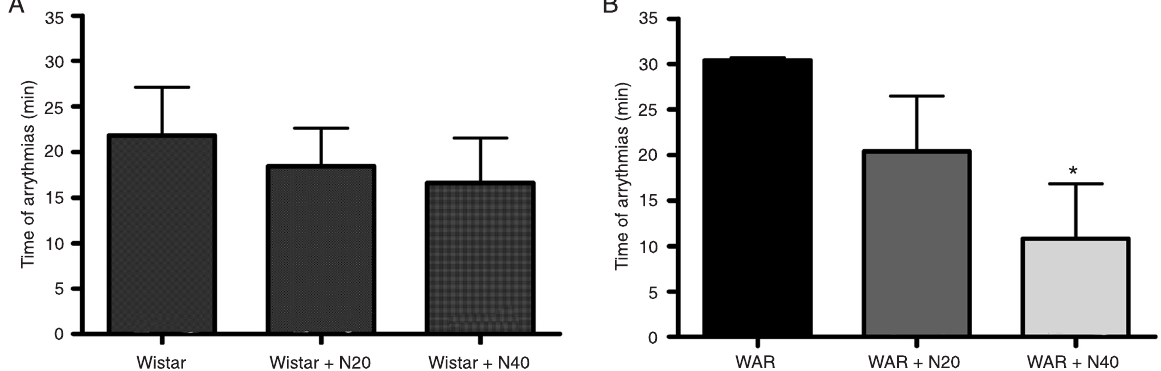
Figure 3. Effects of 20 and 40 mg/kg nifedipine (N20 and N40) on the duration of reperfusion arrhythmias in isolated hearts of A , Wistar rats and B , Wistar audiogenic rats (WAR). Data are reported as means ± SEM for 6 rats per group. *P < 0.05 compared to control (WAR) (one-way ANOVA followed by the Newman-Keuls post-test).